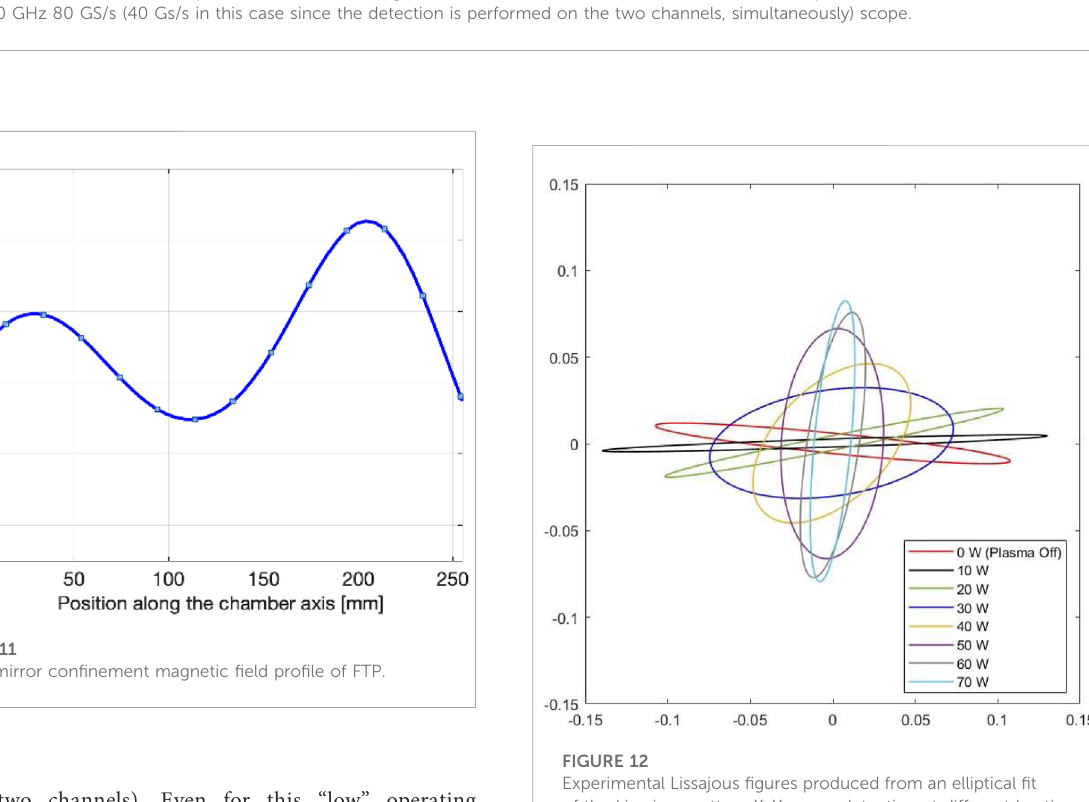
FIGURE 12 Experimental Lissajous fi gures produced from an elliptical fi t of the Lissajous pattern X-Y scope detection at different heating